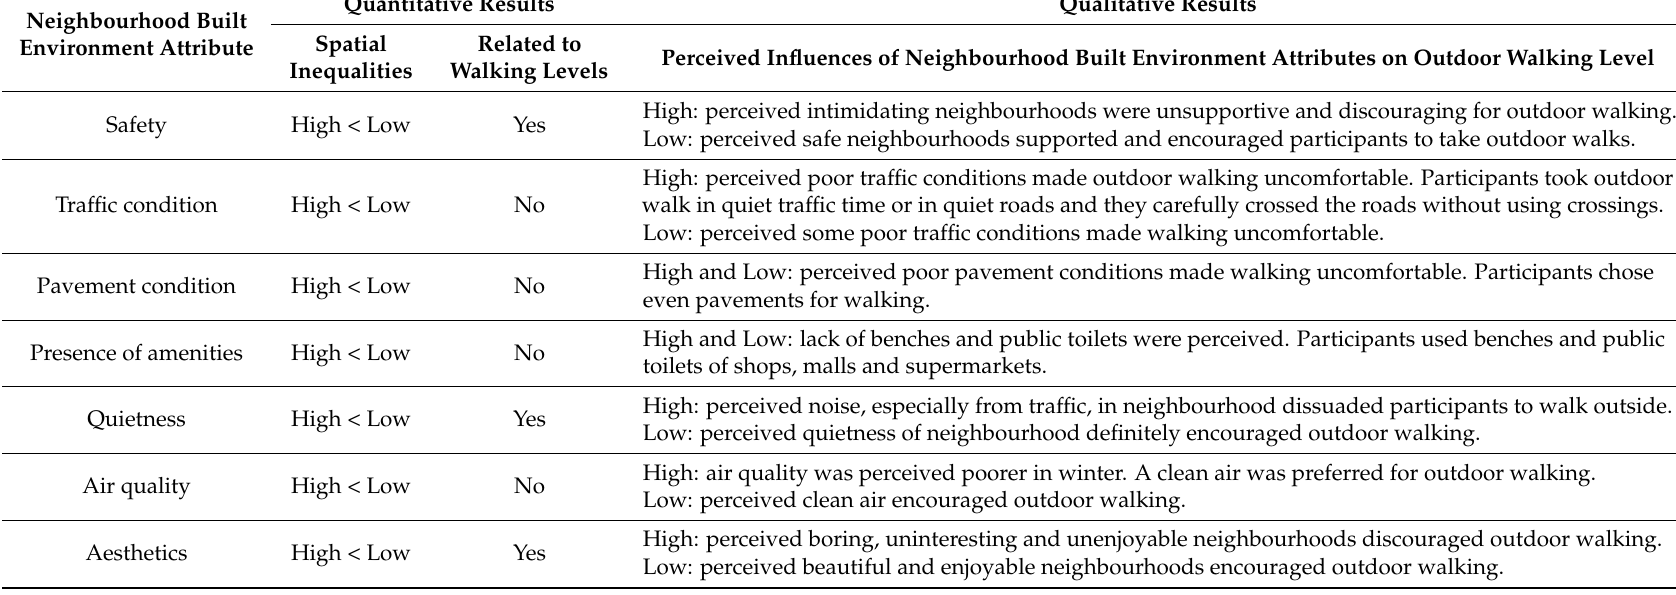
Table 7. Combination of quantitative and qualitative